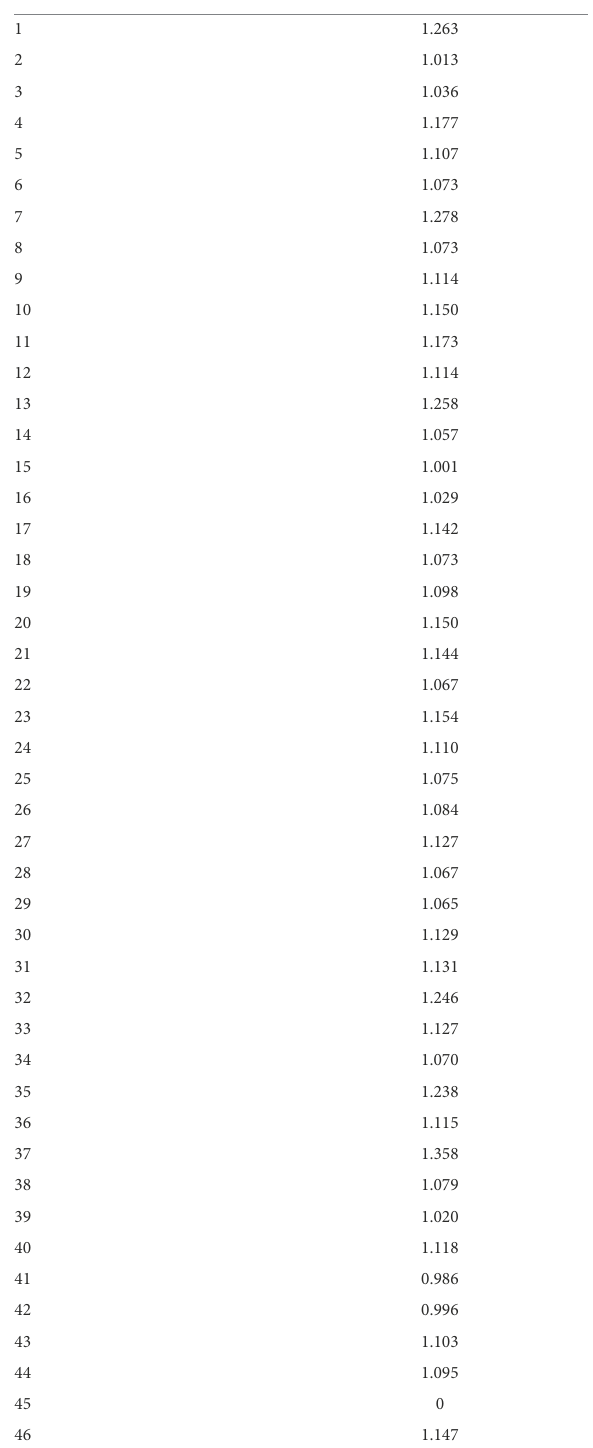
TABLE 1 Growth of P . putida KT2440 (pBBR1MCS-5::mCherry) transferred from the gel-filled well-array device into a 96-deep well